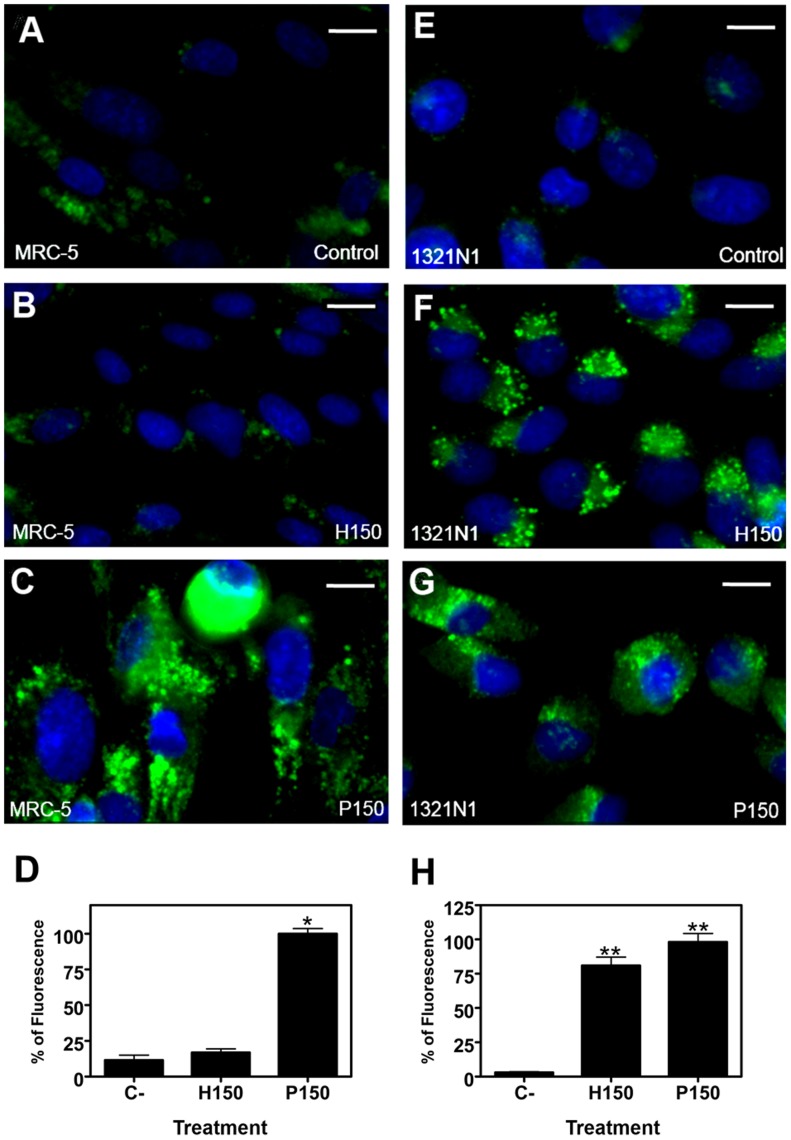
2OHOA induction of acidic vesicles in 1321N1 but not in MRC-5 cells.Analysis of acidic vesicles in cells stained with Hoechst and LysoSensor Green to visualize nuclei and lysosomes, respectively. The images were captured by live cell imaging and they all represent merged images of Hoechst (blue) and LysoSensor Green (green). The acidic vesicles in photomicrographs were analyzed with Image J 1.38x software. Neither the vehicle (FBS, A) nor 2OHOA (150 µM; 48 h, B) resulted in the formation of acidic vesicular organelles (lysosomes and autophagosomes) in non-cancer MRC-5 human fibroblast cells, as detected by the LysoSensor fluorescence probe, whereas palmitate (150 µM, 48 h: C) induced acidic vesicle formation. Graphs show the integrated fluorescence density of the lysosomes (5×104 cells per experiment) in MRC-5 cells (D): Control, 11.54±3.36%; 2OHOA (150 µM), 16.88±2.45%; palmitate (150 µM), 100*±3.65%; *p<0.05. No vesicular organelles accumulated in 1321N1 human astrocytoma cells treated with the vehicle alone (control, E), while exposure to 2OHOA (F) or palmitate (G) (150 µM; 48 h) resulted in the appearance of acidic vesicular organelles. Integrated fluorescence density of lysosomes in 1321N1 cells (5×104 cells per experiment) (H): Control, 3.1±0.37%; 2OHOA (150 µM) 81**±6.18%; P (150 µM) 100**±6.12%; **p<0.01 (n = 6 experiments). Scale bar = 10 µm (8A, 8B, 8E, 8F, 8I, 8J); 15 µm (8C, 8G and 8K).